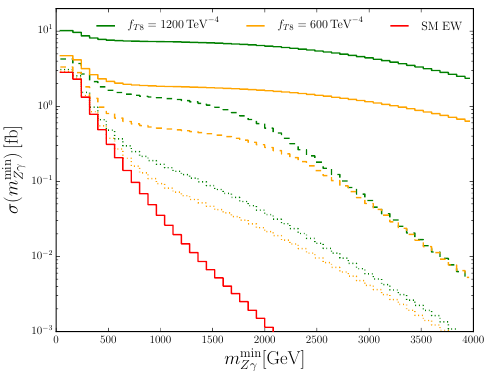
Figure 11 . Dependence of the Z ‘ (cid:13)jj total cross section on an additional cut m min eq. (3.15). The line styles are as given in (cid:12)gure